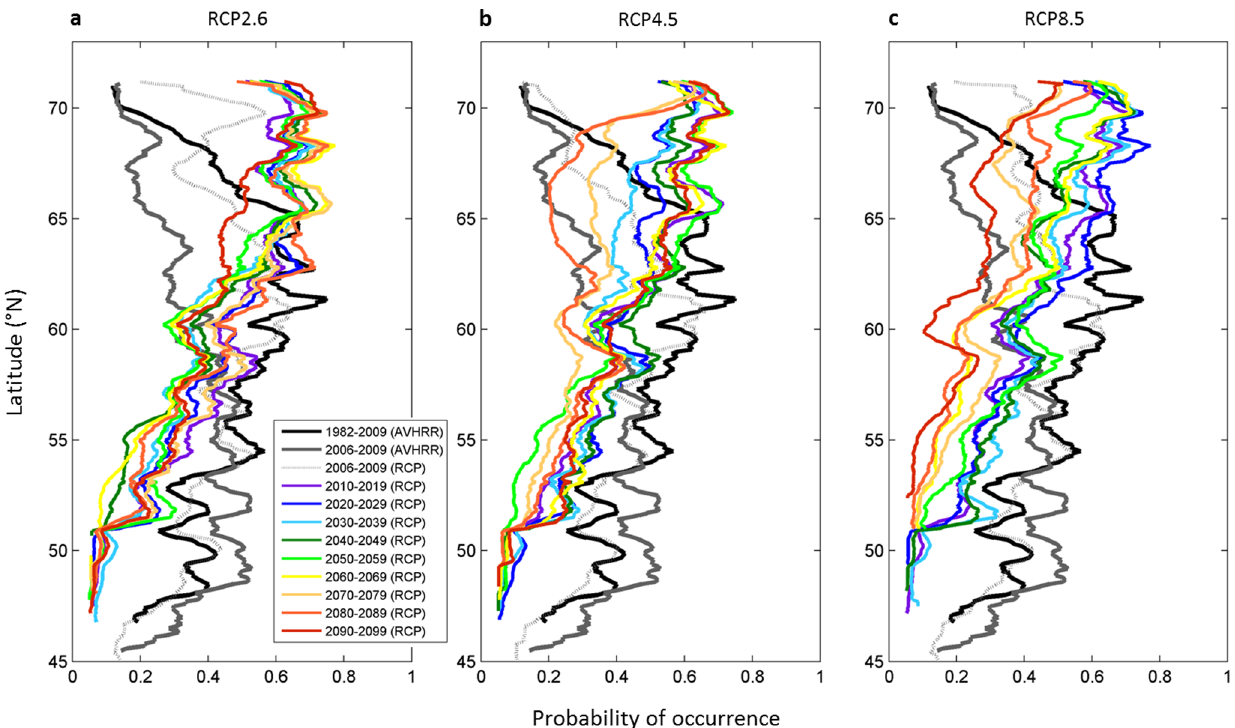
Figure 2. Latitudinal gradient in the probability of occurrence of the kelp Laminariadigitata along the European coasts, calculated for the periods 1982–2009 with AVHRR SST data and for 2006–2009 and each decade of the 21 st century with RCP-SST data. Projected changes in the probability of occurrence are presented for three RCP scenarios: a, the low RCP2.6; b, the medium RCP4.5 and c, the high RCP8.5.